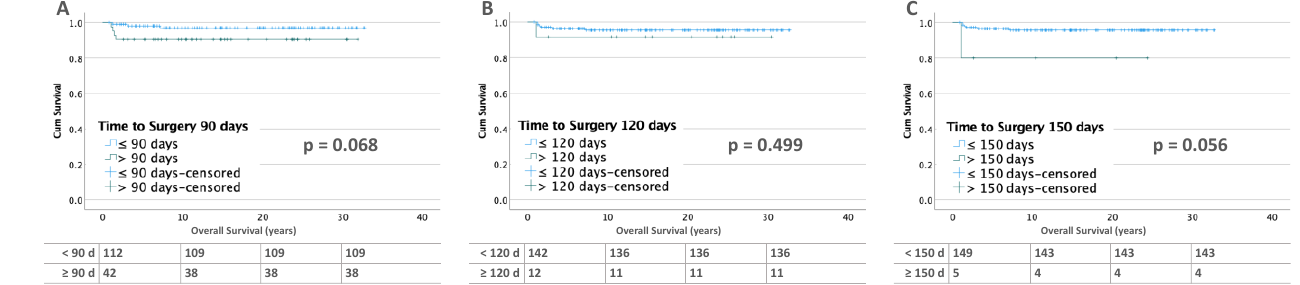
Figure 8. Kaplan–Meier lifetables of OS of bilateral WT without metastases at diagnosis at a thresholds of 90 ( A ), 120 ( B ), and 150 ( C ) days of preoperative chemotherapy. In the tables below the figures, the numbers at risk are reported.